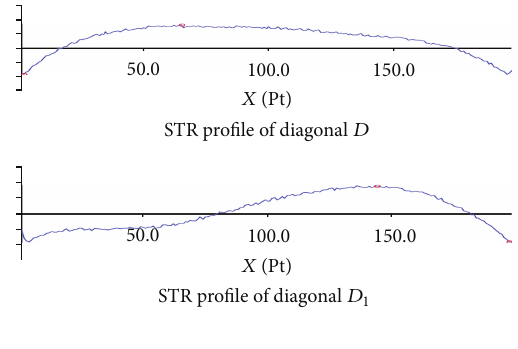
Figure 2: The positions of STR measurement for 𝐷 , 𝐷 1 , 𝐿 , 𝐿 1 , and 𝑀 ; 𝑀 1 , and 3-point plane.